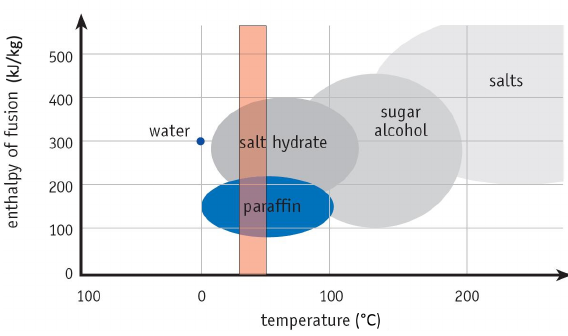
Figure 2. Classes of the phase change materials and their common parameters